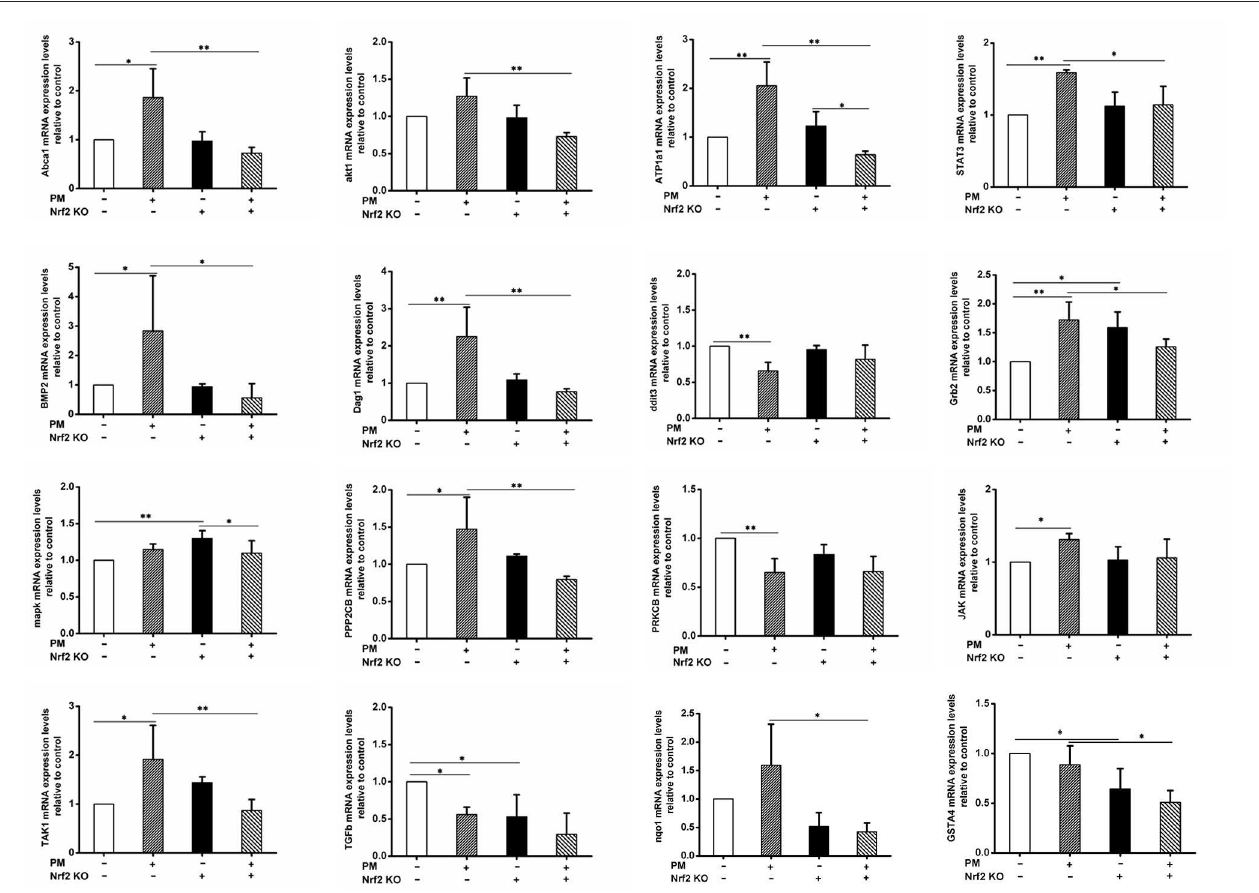
FIGURE 4 | qRT-PCR results. For 6 weeks, 6–8-weeks C57/B6 mice, with or without Nrf2 knockout, were exposed to either filtered air or air containing particulate matter (PM), and then the hearts were collected, snap-frozen in liquid nitrogen, and subjected to quantitative reverse transcription PCR. Primers used included Abca1, akt1, ATP1a1, STAT3, BMP2, Dag1, ddit3, Grb2, MAPK, PPP2CB, PRKCB, TAK1, TGFb, and JAK. N = 3 per group from three independent experiments. *Statistically different between the two groups ( P < 0.05). **Statistically different between the two groups ( P <